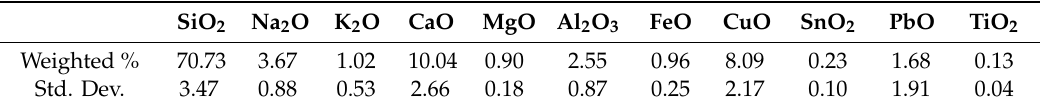
Table 1. Composition expressed in oxide (wt.%) used for the Monte Carlo simulations of Egyptian blue, taken from reference [22]. SiO